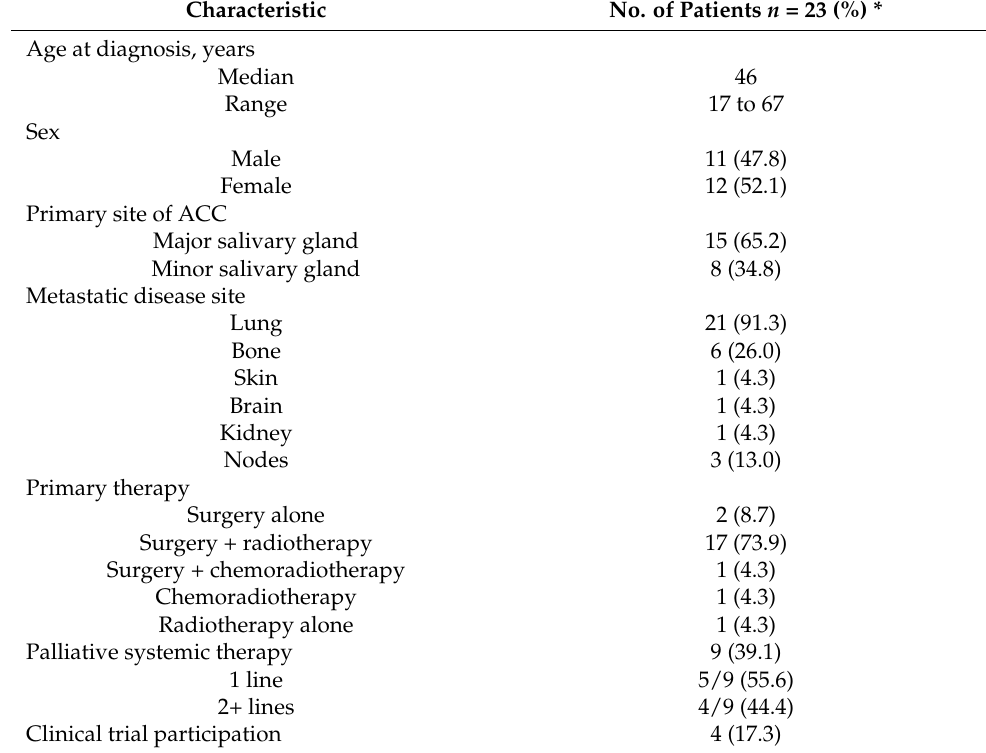
Table 1. Baseline